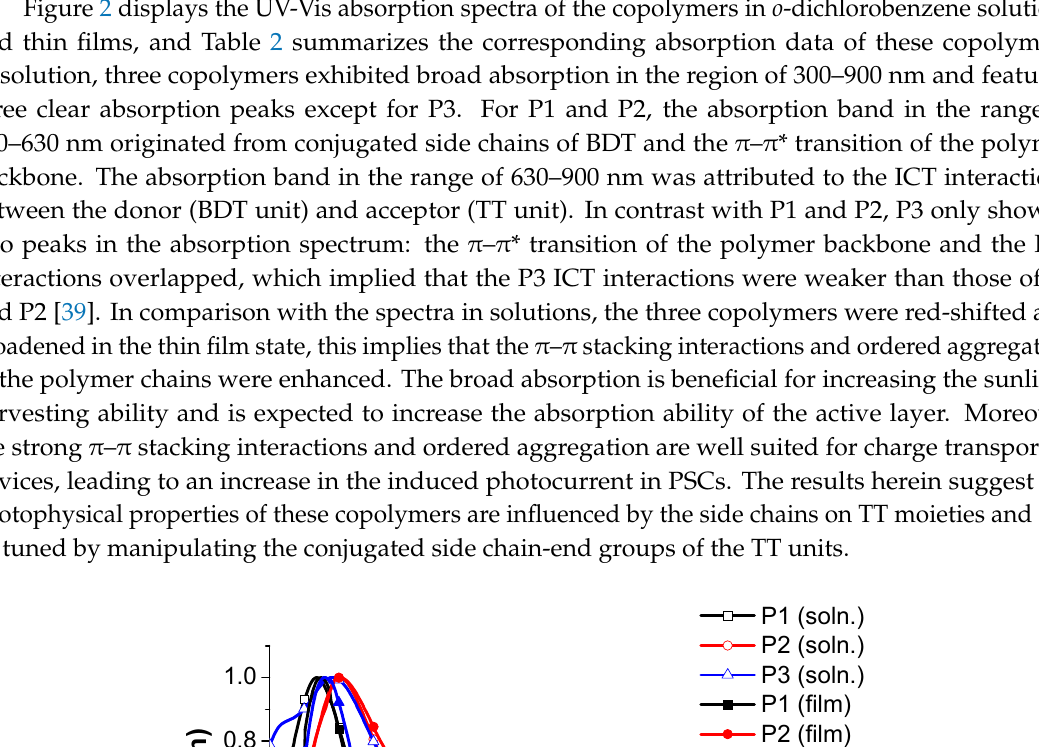
Figure 1. Thermogravimetric analysis (TGA) diagrams of the copolymers at a heating rate of 10 °C/min under nitrogen atmosphere.